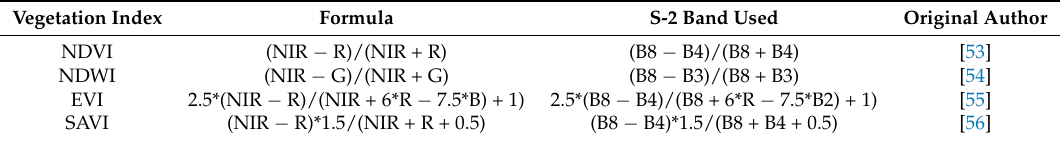
Table 3. Vegetation indices calculated from Sentinel-2 images for the Spanish study area. B= Blue band, G = Green band, R = Red band, NIR = Near-infrared band. NDVI = Normalized difference vegetation index, NDWI = Normalized difference water index, EVI = Enhanced vegetation index, SAVI = Soil adjusted vegetation